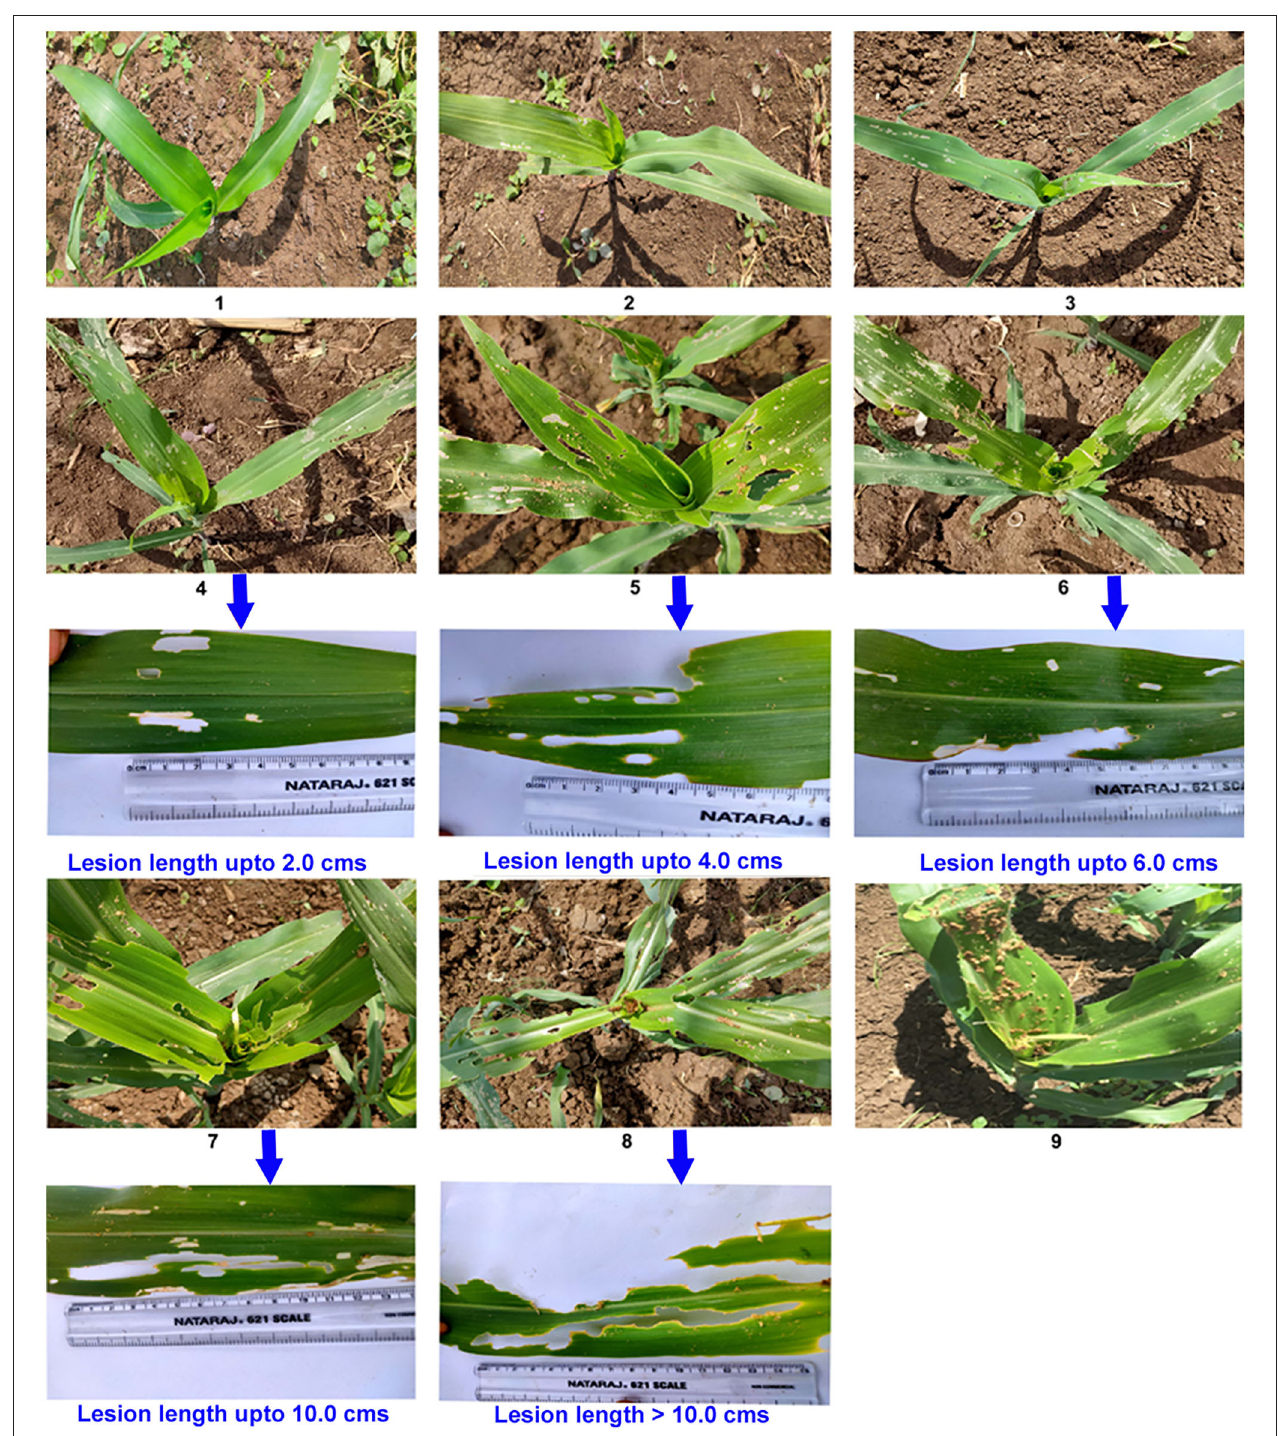
FIGURE 1 | Simple 1–9 whole plant leaf damage scale for the fall